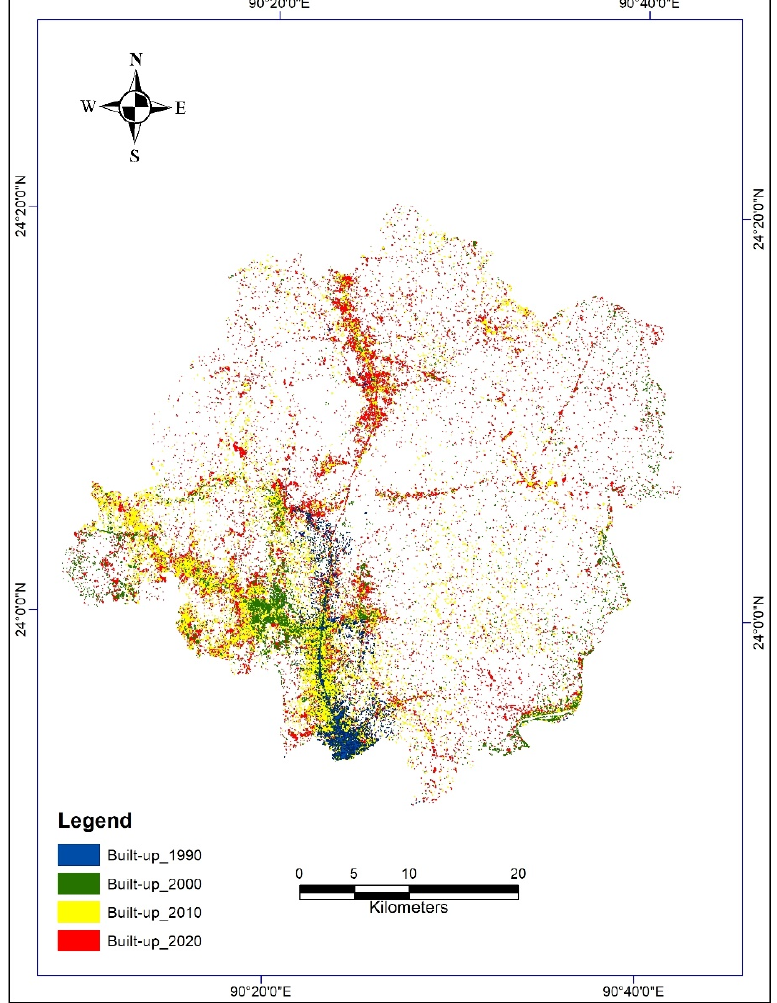
Figure 7. Expansion of built-up area (1990–2020).